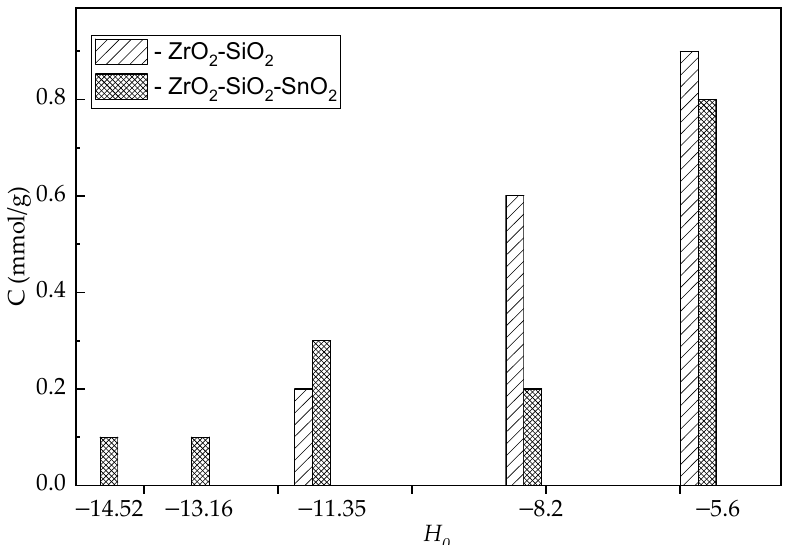
Figure 3. Concentration–strength acid site distribution for ZrO 2 –SiO 2 and ZrO 2 –SiO 2 –SnO 2 samples. In comparison, the ZrO 2 –SiO 2 surface contained acid sites of only medium strength (~45%) (Figure 3). The presence of octahedral and tetrahedral-coordinated Sn 4+ on the